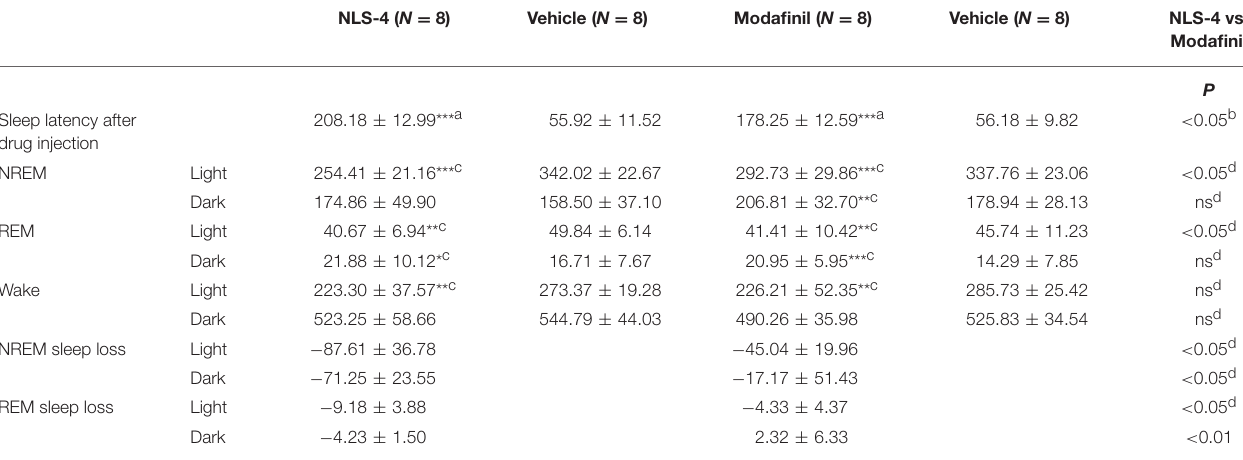
TABLE 1 | Distribution of vigilance states during the 24h after drug